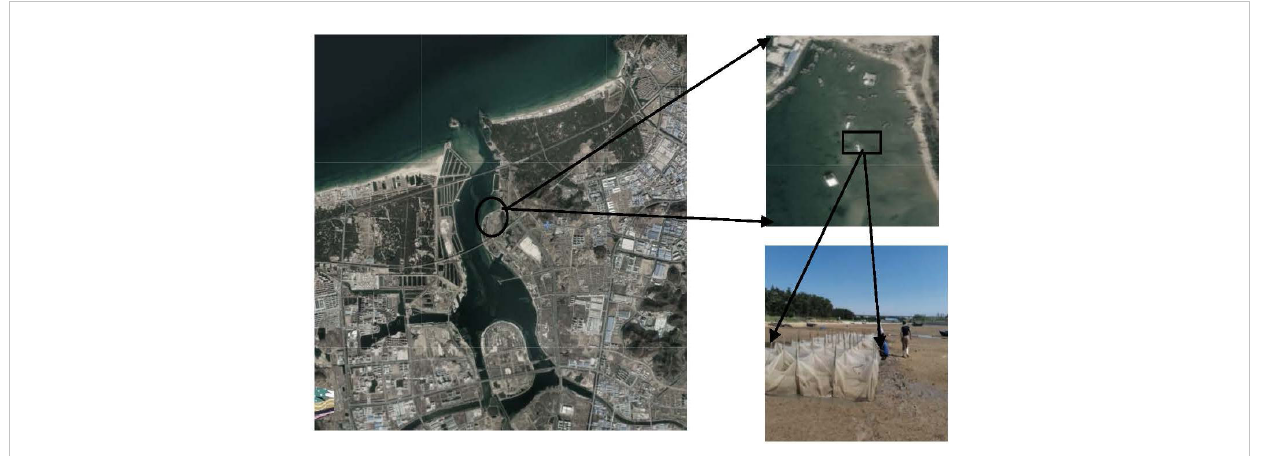
FIGURE 1 Layout of fi eld investigation conducted in Shuangdao Bay.